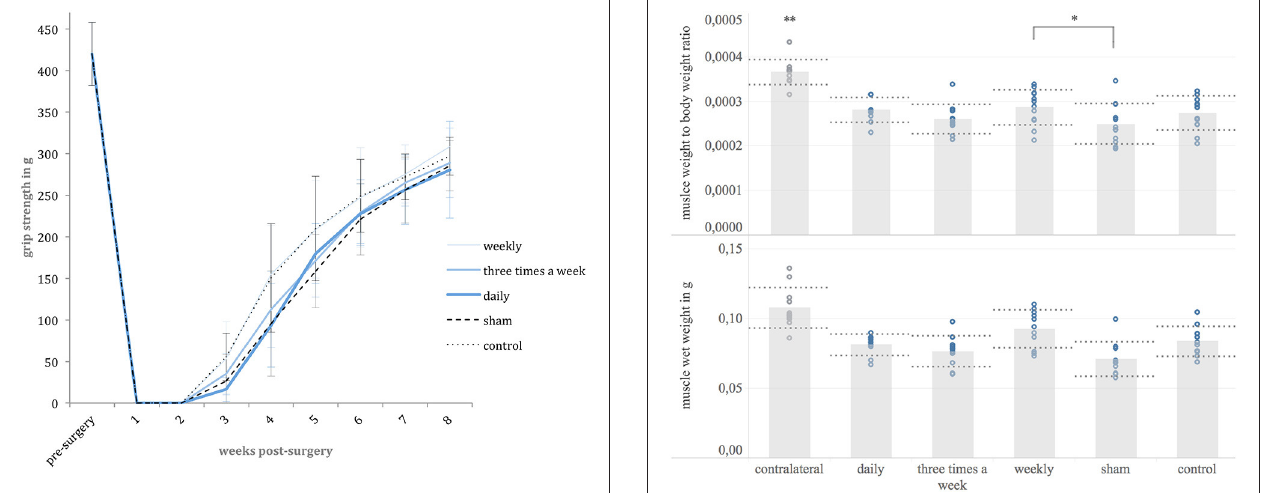
FIGURE 4 | Grip strength level. Shown are the mean pre-surgery grip strength and weekly post-surgery mean grip strength values in gram [g] with standard deviation for each experimental group.